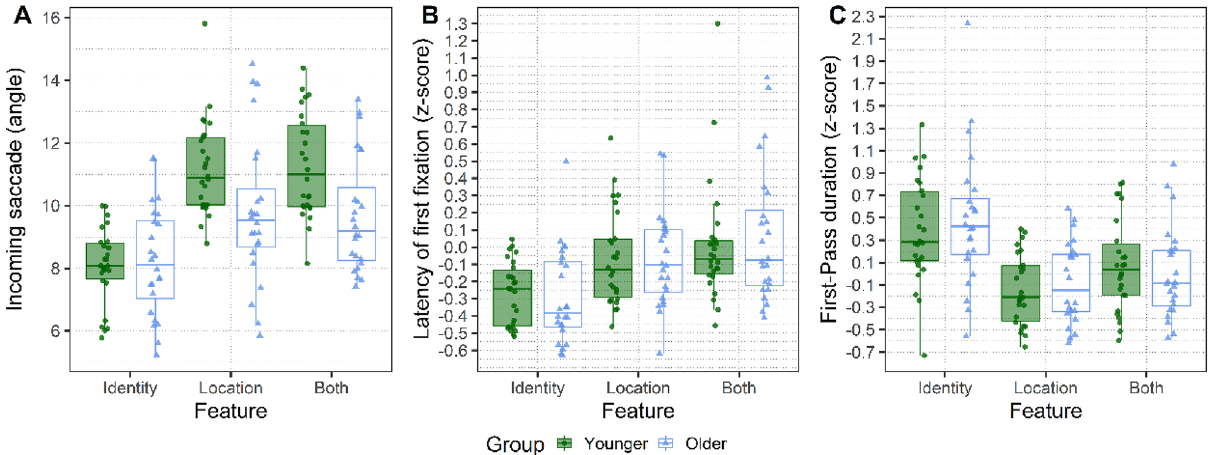
Figure 6. Eye-movement measures on the Current Location: ( A ) Incoming saccade amplitude of first fixation on the critical object in degrees of visual angle, ( B ) Latency of the first fixation on the critical object (z-scores), and ( C ) the summed duration of all fixations on the critical object before exiting it for the first time (First- Pass, also in z-scores). The two Groups of participants are compared within each panel. The Younger group is depicted in green, whereas the Older group is depicted in blue. The hinges of the boxplots represent the 25th and 75th percentiles of the measure (lower and upper quartiles). The horizontal line represents instead the median of the distribution. Each dot indicates the by-participant average for that factor.